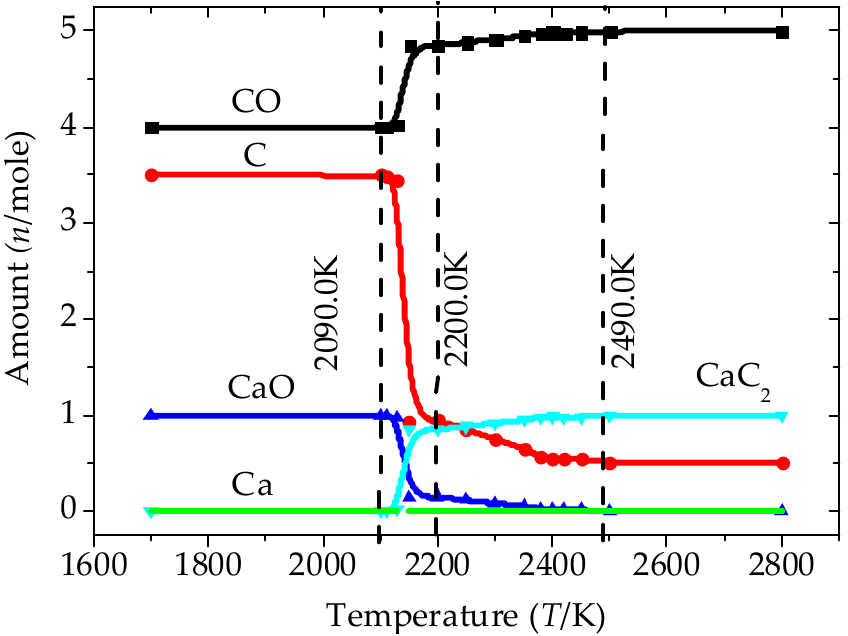
Figure 12. The conversion of C and CaO at each reaction temperature.